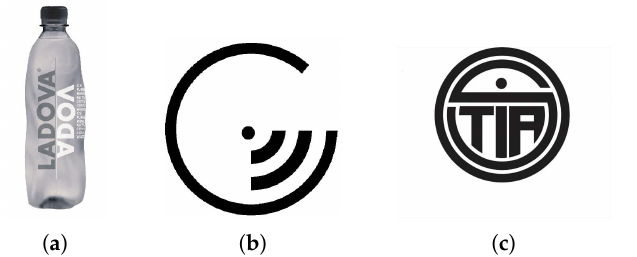
Figure 9. Selected test images used for algorithm retrieval efficiency evaluation: ( a ) input A; ( b ) input B; ( c ) input C.